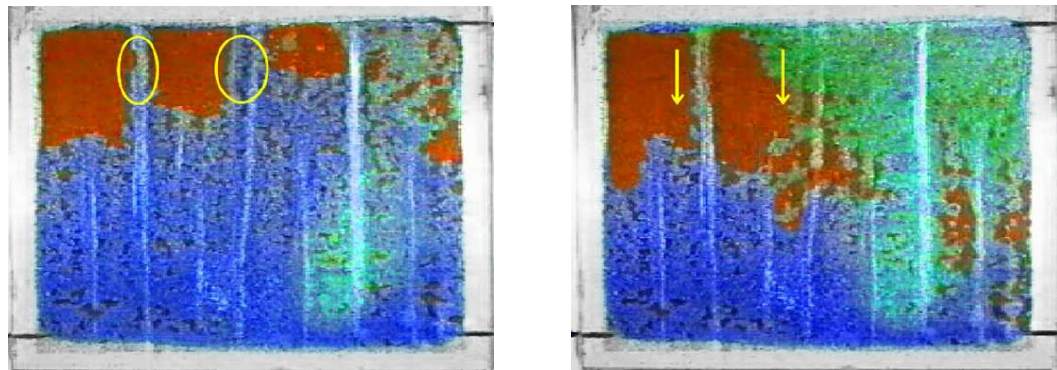
( c ) (the arrow represents injection channel of gelant)